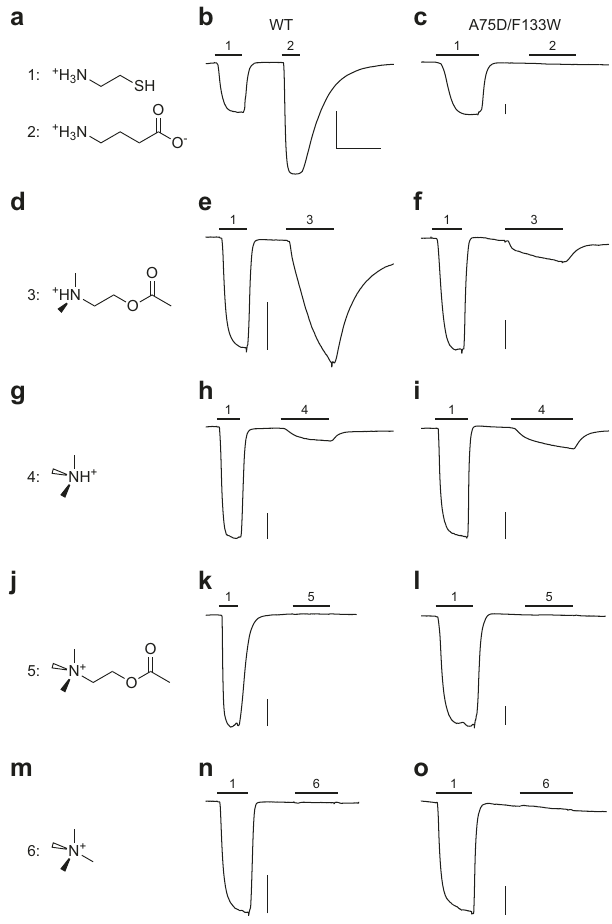
Fig. 4 Activity of wild-type (WT) and the A75D/F133W double mutant ELIC in the presence of various amines. Representative whole-cell responses for WT and the A75D/F133W double mutant ELIC are shown when 25 mM a – c GABA (compound 2), d – f 2-dimethylaminoethyl acetate (DMAEA; compound 3), g – i Trimethylamine (compound 4), j – l ACh (compound 5), or m – o Tetramethylammonium (compound 6) are added at the indicated times. In each case, an initial application of cysteamine at its respective EC 50 was added as a positive control (compound 1), while the second application is the response after application of 25 mM of the indicated amine (compounds 2 – 6). The vertical scale bar for each panel represents 0.5 μ A, while the horizontal bar shown in panel b represents 1 min and applies to all